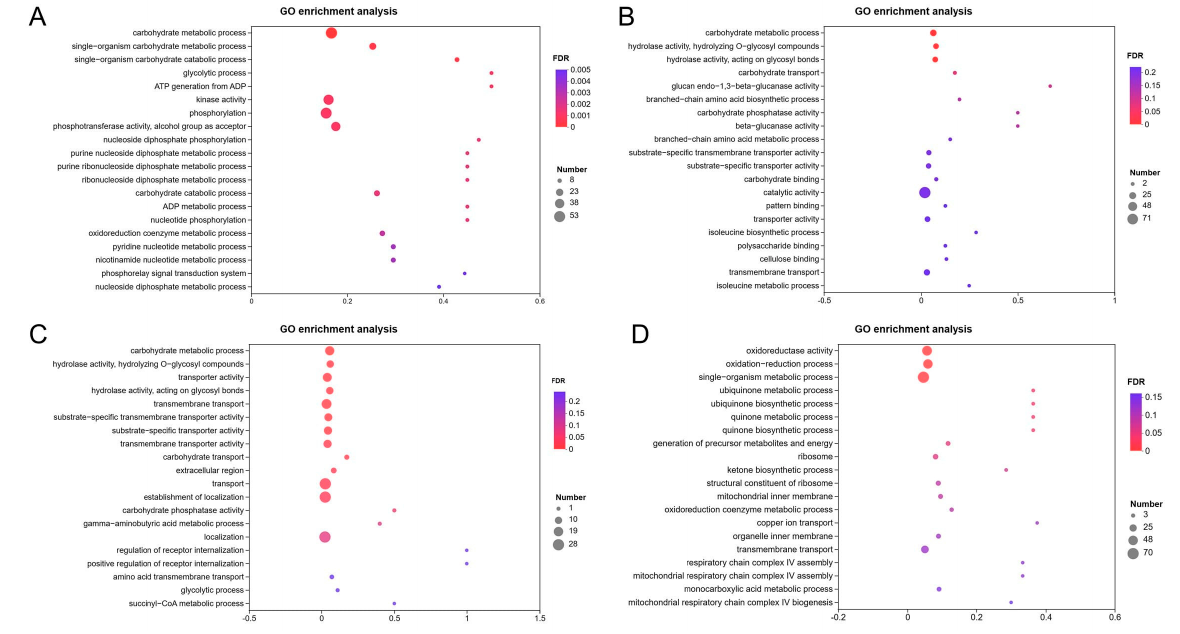
Figure 3. GO enrichment analysis bubble diagram showing all upregulated DEGs in T. harzianum T4 grown for 12 h ( A ), 24 h ( B ), 48 h ( C ), and 72 h ( D ) in the presence of BCCW. The ordinate represents the GO classification description, and the abscissa rich factor represents the ratio of differentially expressed genes of this term to all genes that were annotated in the term. Table 2. Significantly enriched KEGG pathways ( q ≤ 0.05) of DEGs in T. harzianum T4 grown for 12, 24, 48 and 72 h in the presence of